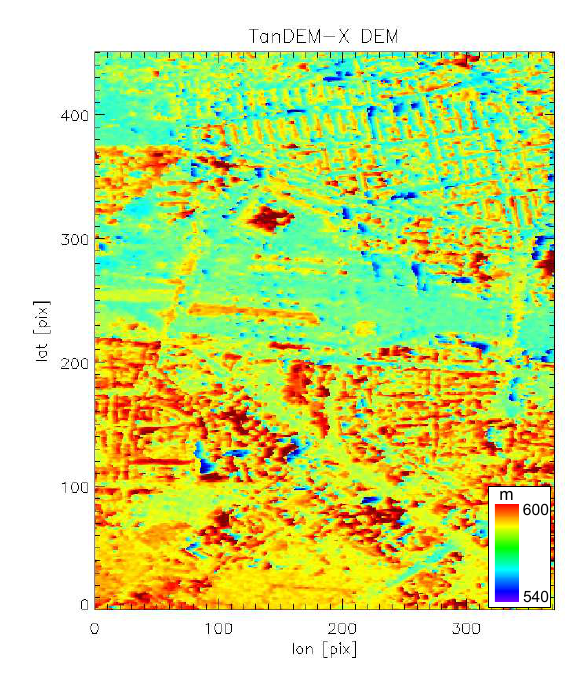
Figure 1: TanDEM-X operational raw DEM over the western part of Munich.